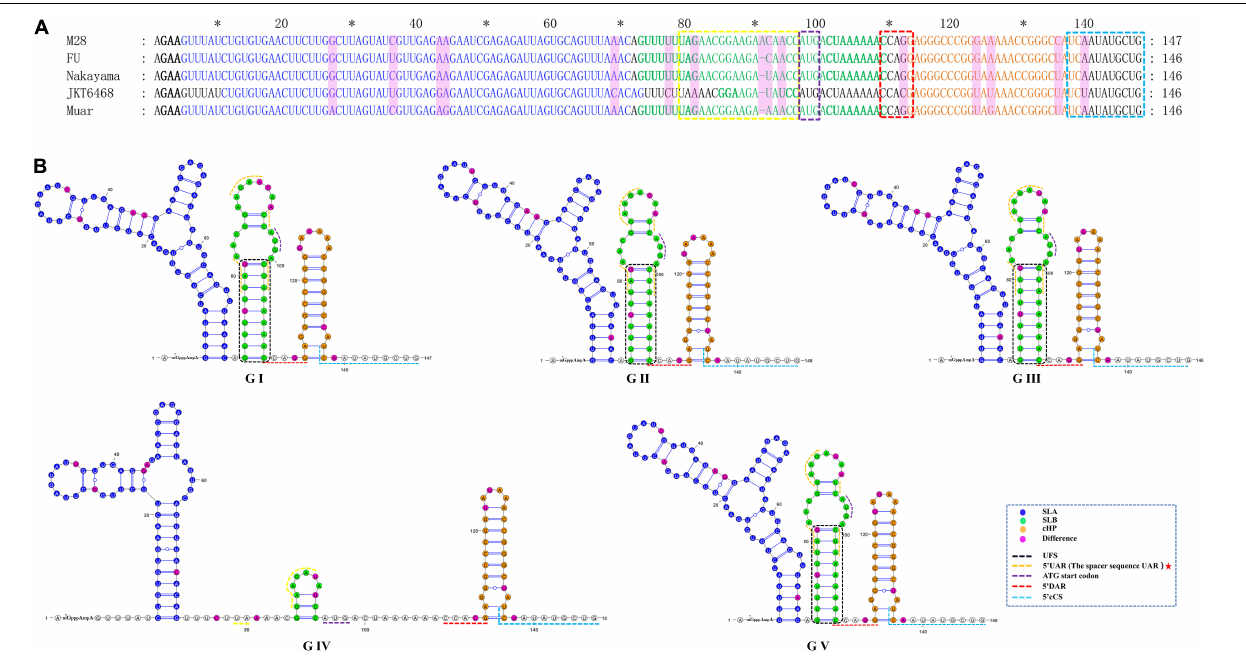
FIGURE 5 | The primary and higher-order structures of the 5 (cid:48) UTRs of JEV. (A) The primary sequences of the JEV 5 (cid:48) UTRs. (B) The higher order structures of the JEV 5 (cid:48) UTRs. Differently colored nucleotide bases signify different cis -acting elements or significant units: bold black, 5 (cid:48) Cap (m 7 G ppp A mp A); blue, the stem-loop A (SLA); green, the stem-loop B (SLB); yellow box, the upstream AUG region (5 (cid:48) UAR); blue box, the ATG start codon; bold green, the 5 (cid:48) UAR-flanking stem (UFS); orange, the capsid-coding region hairpin element (cHP); red box, the 5 (cid:48) downstream AUG region (5 (cid:48) DAR); aquamarine, 5 (cid:48) cyclization sequence (5 (cid:48) cCS). The mutation sites are colored magenta. The mentioned units are colored similarly in the higher order structures. Black dashed box, yellow dashed lines and red dashed lines, respectively, denote the UFS, 5 (cid:48) URA, and 5 (cid:48) DAR, which were overlapped with other structures and sequences. The red pentagram represents the sequence motif with unique JEV